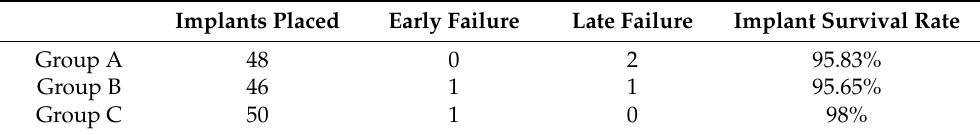
Table 3. Implant failure before or after the osseointegration period (6 months) and implant survival rates according to the surgical procedure at the end of the follow-up period (4 years).